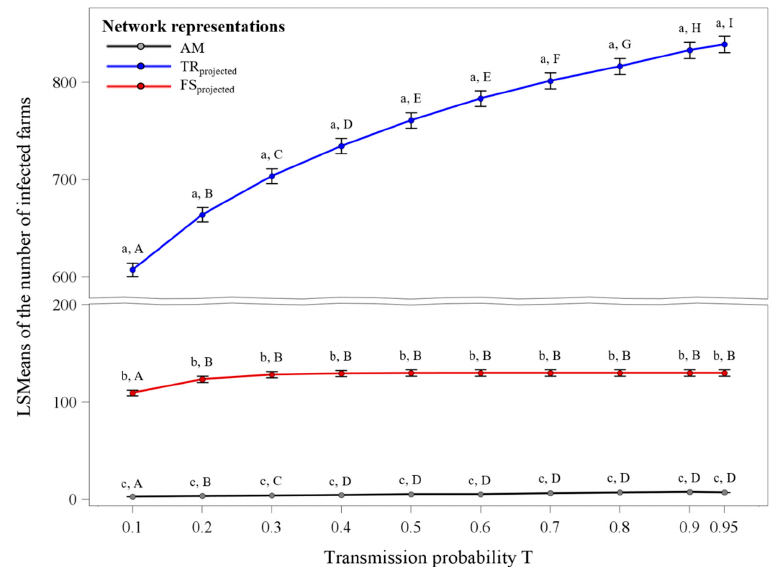
Figure 5. LSMeans ± standard error of the number of infected farms in dependence of the three different network representations and the transmission probability. (a–c) Significant differences between the network representations within each transmission probability. (A–I) Significant differences between the transmission probabilities within each network representation ( p ≤ 0.05).